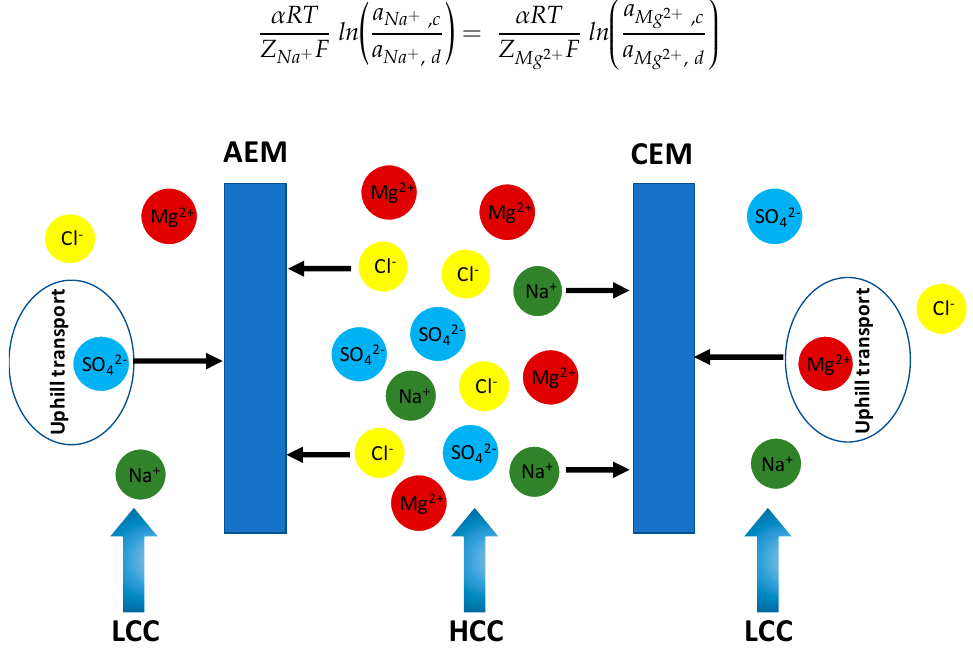
Figure 3. Illustration of uphill transport.